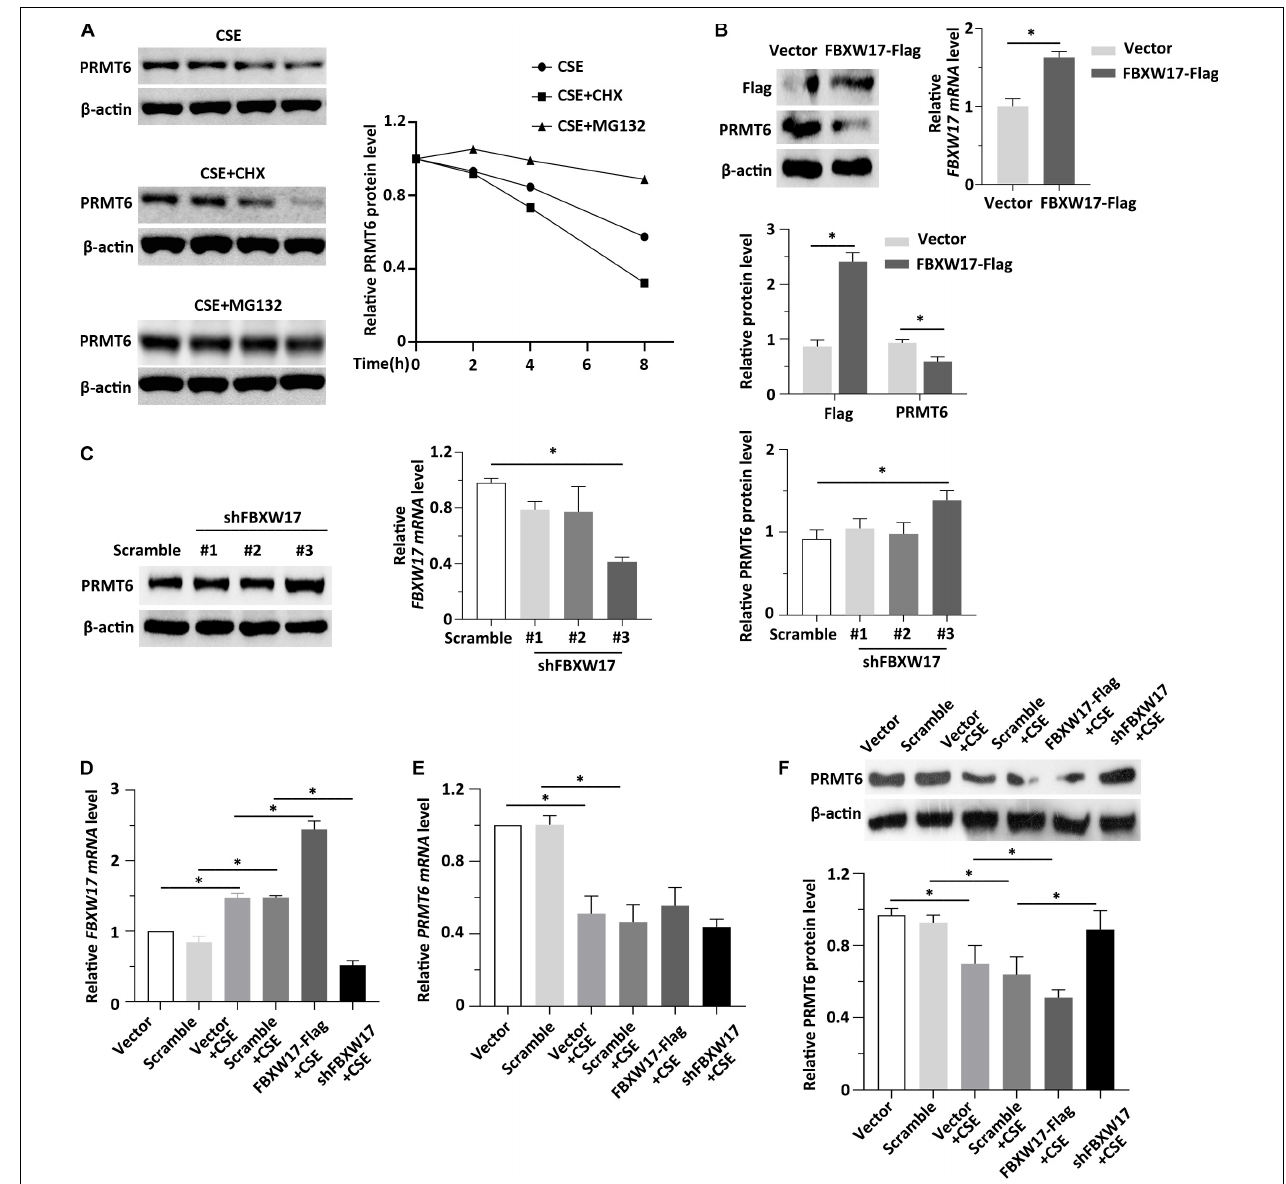
FIGURE 5 | FBXW17 promotes cigarette smoke extract (CSE)-induced protein arginine N-methyltransferase 6 (PRMT6) degradation. (A) The MLE12 cells were stimulated with 5% of CSE and cycloheximide (CHX) or MG132. Cell lysates were subjected to immunoblotting for PRMT6 and β -actin separately. The densitometry results of PRMT6 protein expression are plotted in the right-hand panel. (B) MLE12 cells were transfected with vector or FBXW17 overexpression plasmids via electroporation for 48 h. The messenger RNA (mRNA) of FBXW17 was detected using quantitative real-time PCR (qRT-PCR). The data was plotted in the right panel. The relative protein expression of FLAG and PRMT6 were assayed with Western blotting. Densitometry of FLAG and PRMT6 was presented in the lower panel. (C) Scramble small hairpin RNA (shRNA) and three kinds of FBXW17 shRNA were delivered into MLE12 cells by using Lipofectamine 2000 reagent for 72 h. FBXW17 mRNA and PRMT6 protein were determined. The plotted FBXW17 mRNA and PRMT6 protein expression were presented in the middle panel and the right panel. (D–F) Vector, FBXW17-FLAG plasmid, scramble shRNA, and FBXW17 shRNA were separately transfected into MLE12 cells. Before the cells were collected, the transfected cells were stimulated with 5% CSE for 6 h. Total RNA was collected by Trizol reagents. The mRNA levels of (D) FBXW17 and (E) PRMT6 were determined with qRT-PCR. (F) Cell lysate was collected and conducted with PRMT6 or β -actin immunoblotting. The densitometric data of PRMT6 protein expression was plotted in the lower panel. Data represent n = 3 separate experiments. The graph shows mean ± SD, and “ ∗ ” denotes p < 0.05. The differences between each group were indicated by black line and “ ∗